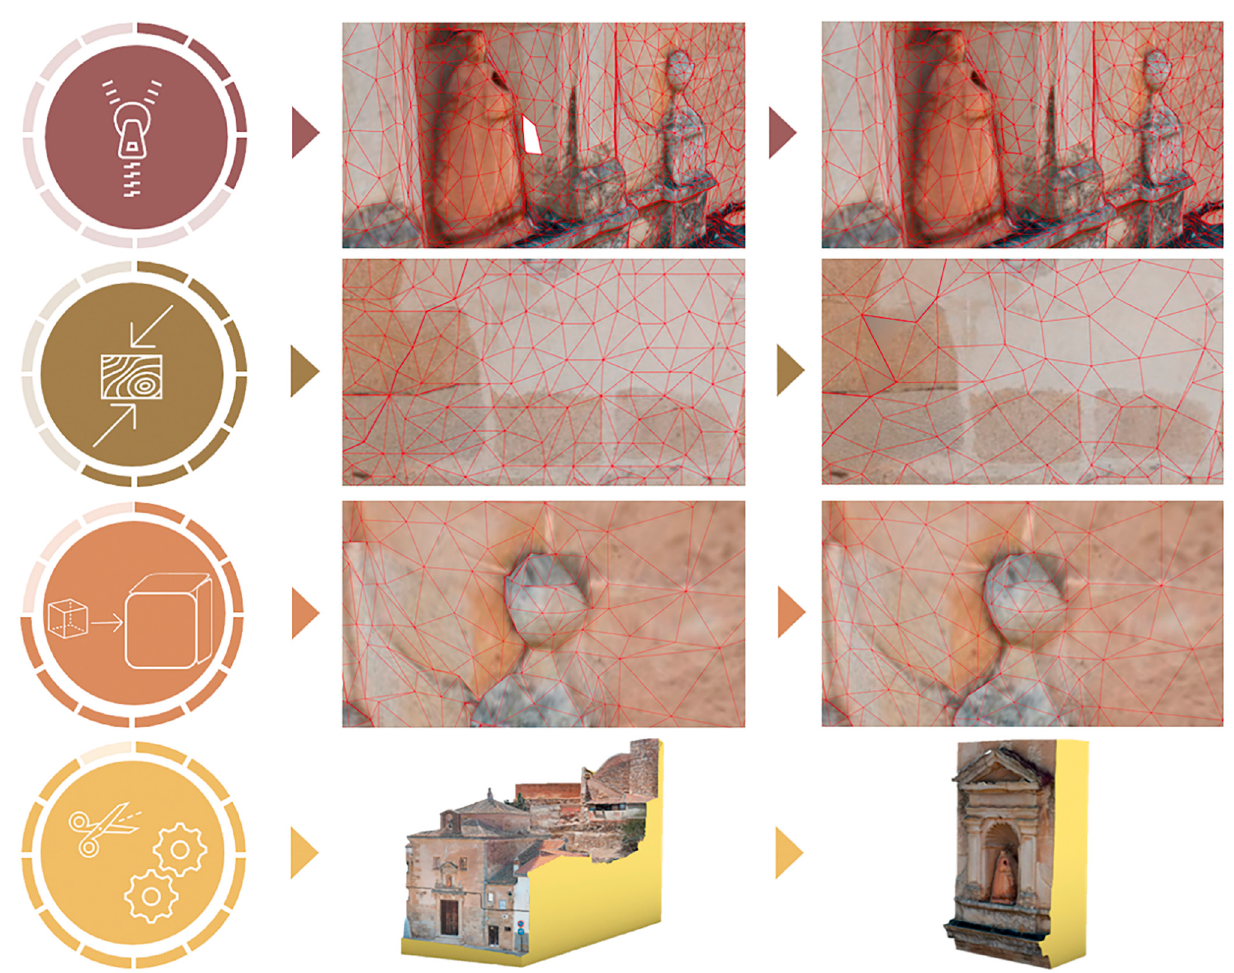
Figure 9. Optimization, debugging and preparation of the digital twin for inclusion in the metaverse.